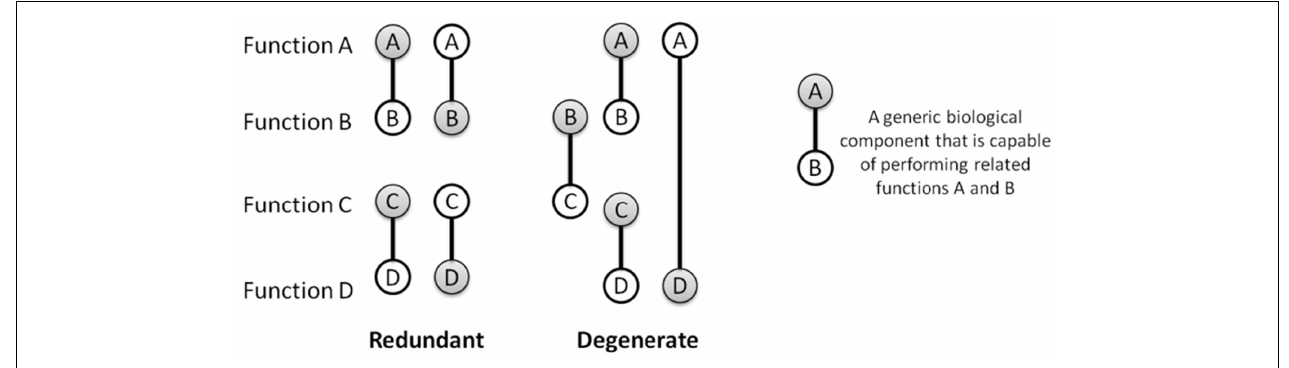
either (purely) redundant, i.e., perfectly identical in functional capabilities, or degenerate, i.e., diverse in their bi-functionality while also having overlap in one of their functions (partial redundancy). Node shading indicates a functional role that is invoked within a particular environmental